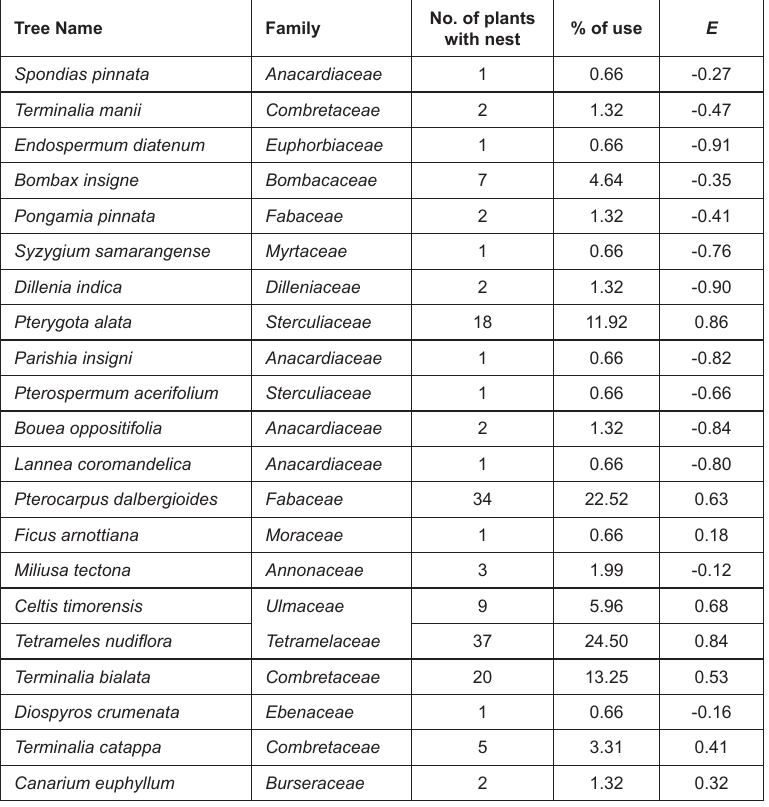
Table 1. Nest plant species utilized by the Andaman